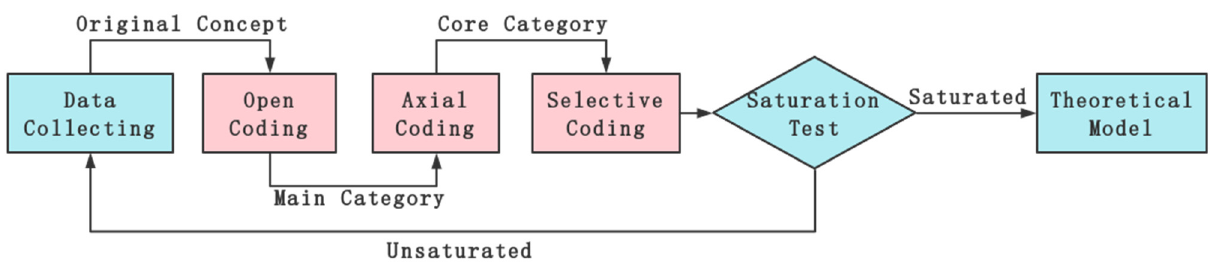
Figure 2. Elements of grounded theory.